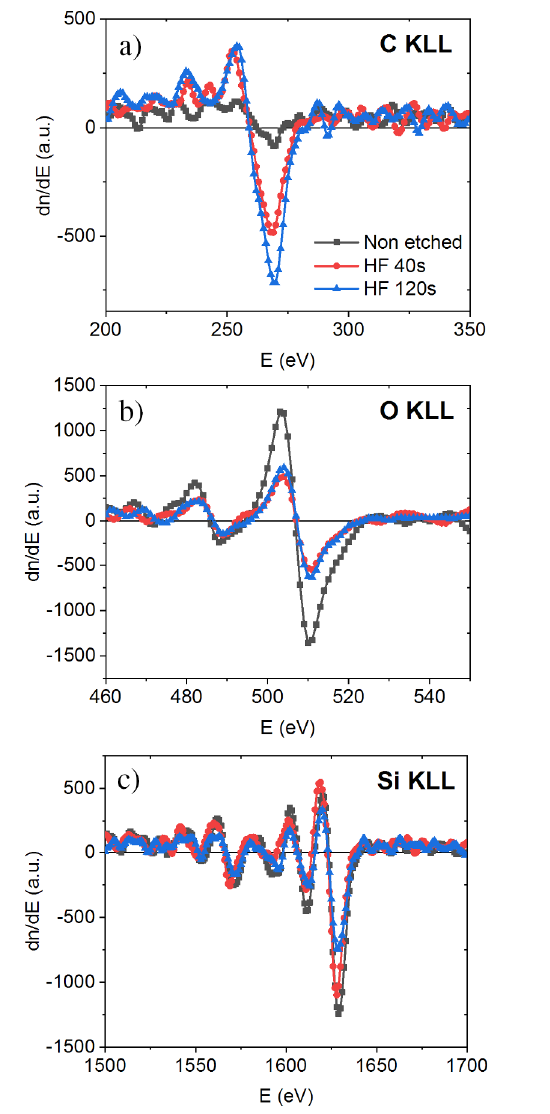
Fig. 2. Auger KLL spectra for highly p -doped Si surfaces (non- etched, 40” and 120” HF etching): (a) carbon, (b) oxygen and (c)